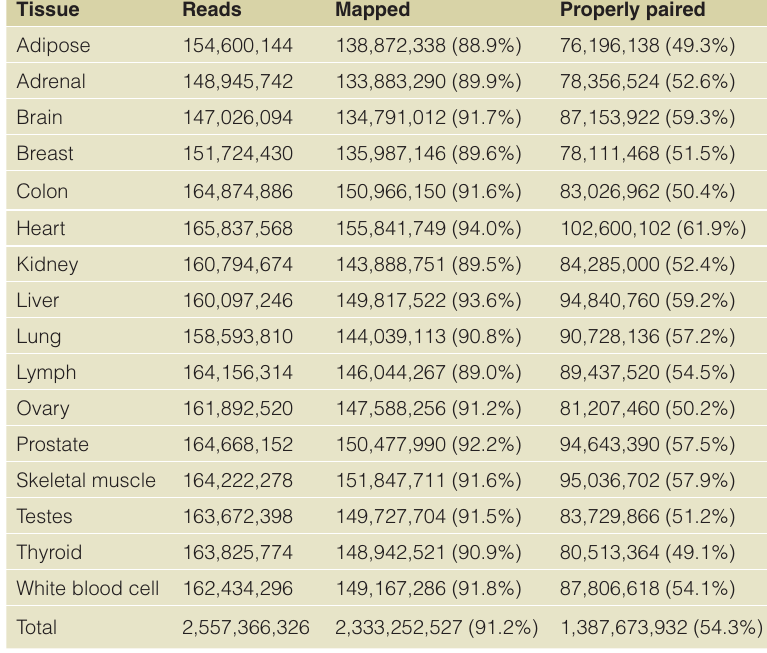
Table S1. Total number of RNA-seq reads from each of 16 human tissues. “Mapped” refers to the number of reads that had at least one and no more than ten alignments to the genome.